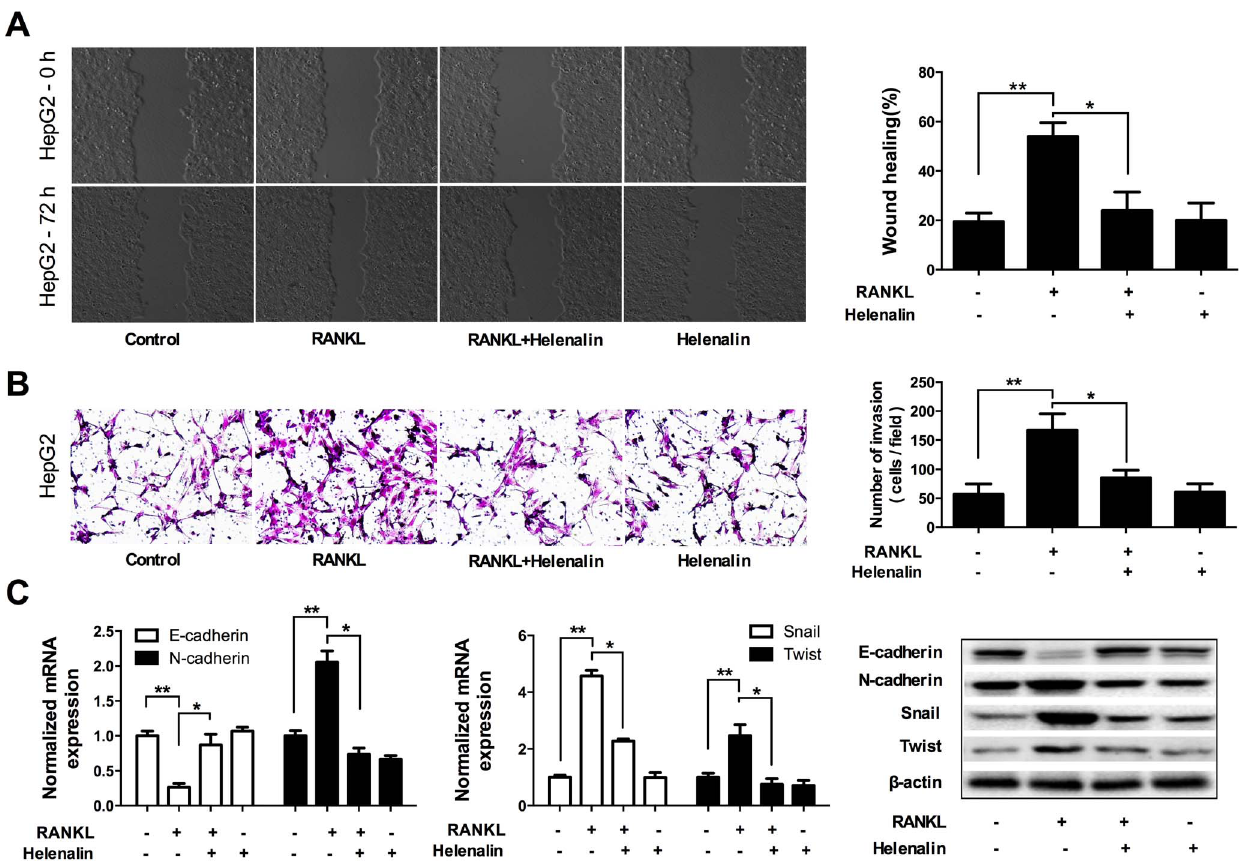
Figure 4. NF- k B pathway was involved in RANKL-induced migration, invasion and EMT of HCC cells. HepG2 cells were pretreated with 1 m M helenalin for 60 min, followed by incubating with 100 ng/ml RANKL for 24 h. A. Wound healing assay showed that pretreatment of HepG2 cells with helenalin significantly suppressed RANKL-induced cell migration. B. Transwell assay indicated helenalin abolished RANKL-induced invasion. C. qRT-PCR and Western blot showed that pretreatment with helenalin in HepG2 cells resulted in down-regulation of E-cadherin and up-regulation of N- cadherin, Snail, and Twist. ** p , 0.01 compared with control, * p , 0.05 compared with RANKL-treated group.